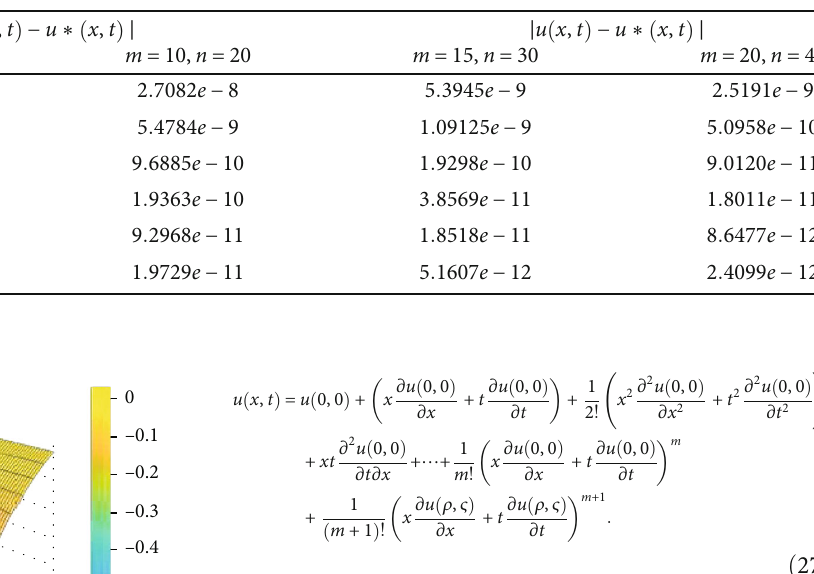
Table 3: Absolute error for di ff erent values of m , n for Example 7.